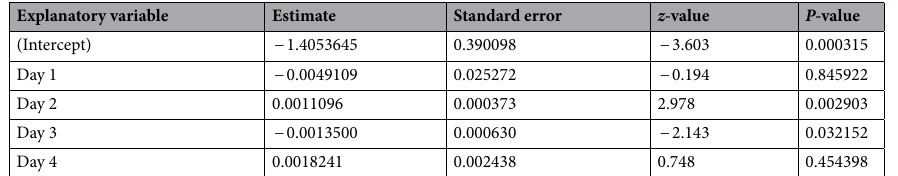
Table 2. Results of logistic regression analysis examining the effects of the number of photos of potential pollinators taken at floral reproductive organs of lotus flowers during each Day of flowering on seed set. The number of photos of all flower-visiting pollinator insects on each Day was summed up. The number of mature seeds was assumed to follow a binomial distribution, with the number of ovules in the flower as the upper limit. Before the analysis, it was confirmed that there was no multicollinearity among the explanatory